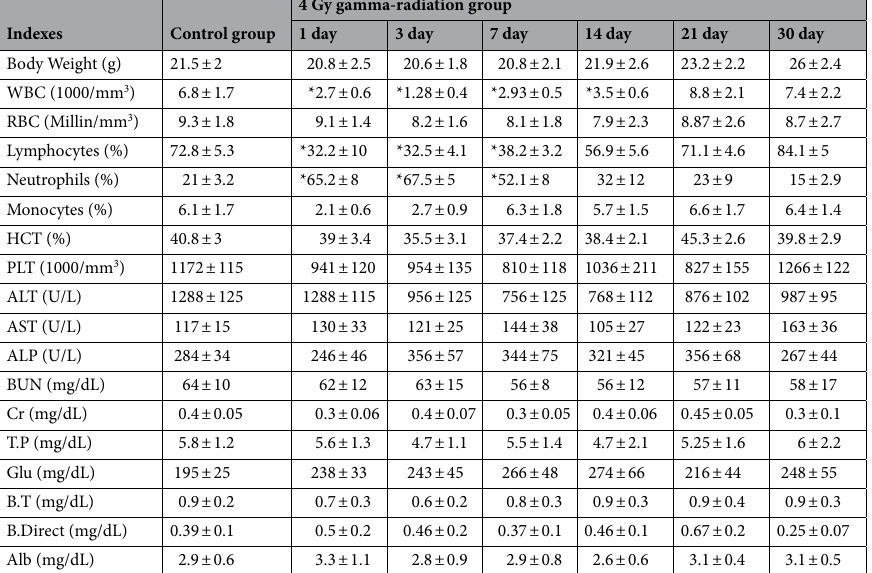
Table 2. The hematological and biochemical parameters in the effects of 4 Gy gamma radiation on 1, 3, 7, 14, 21, and 30 days post-irradiation. Values are means ± SD. RBC = red blood cell, HCT = hematocrit, WBC = white blood cells, Plt = platelets, BUN = blood urea nitrogen, Cr = creatinine, Glu = glucose, AST = aspartate transaminase, ALT = alanine transaminase, ALP = alkaline phosphatase, Alb = albumin, T.P = total protein, B.T = Bilirubin Total, B.Direct = Bilirubin Direct.